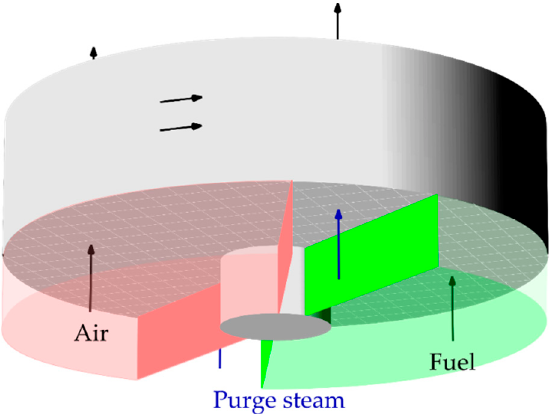
Figure 4. Schematic overview of the rotating chemical looping reactor system. 318